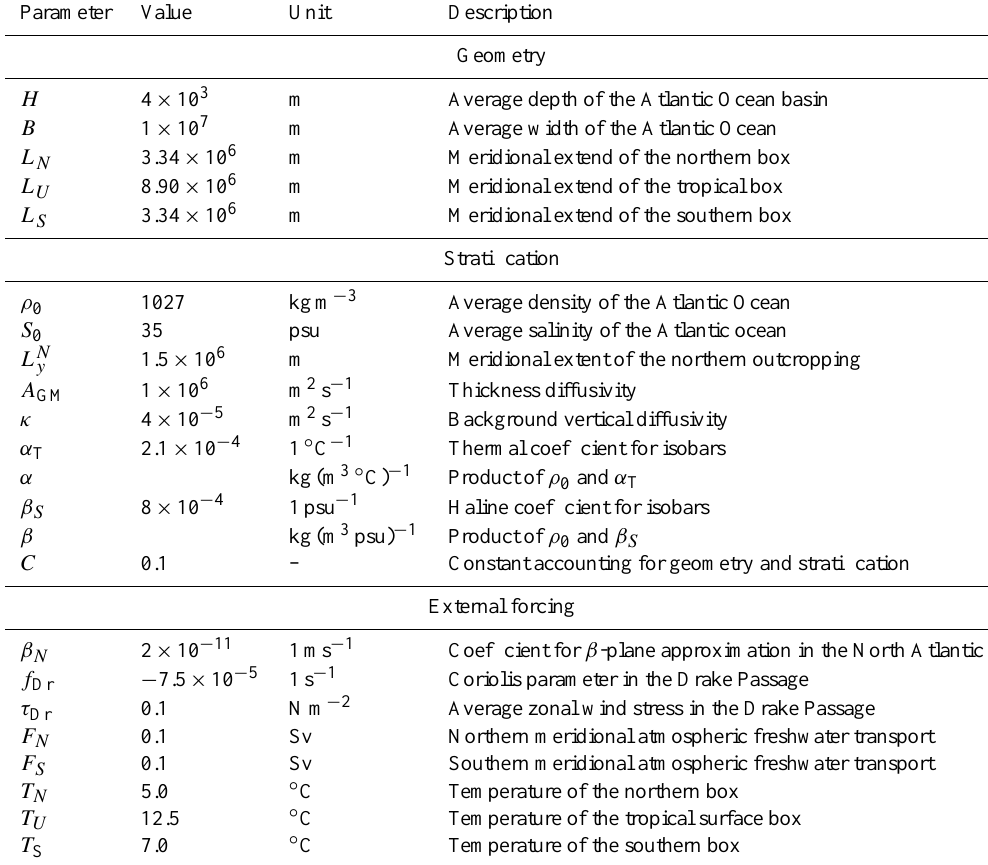
Table 1. Physical parameters for used for the model. Parameter Value Unit